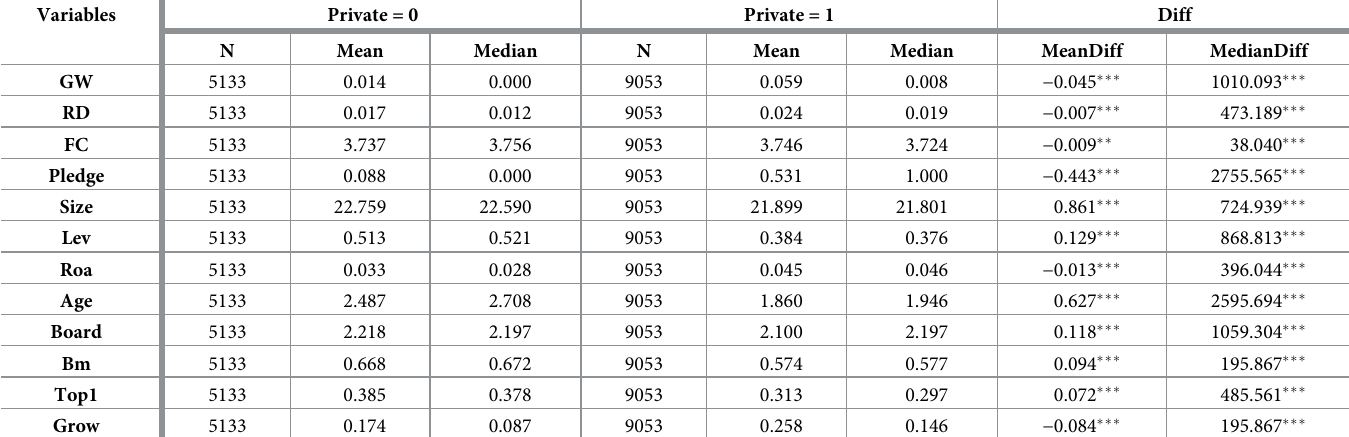
Table 4. Univariate